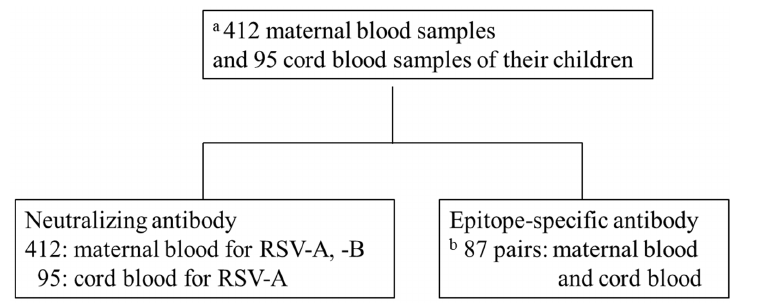
Figure 2. Schematic diagram of analysis. ( a ) Of 9,643 births in Fukushima Prefecture from November 2011 to April 2014, 412 maternal blood (MB) and 95 cord blood (CB) samples of the offspring were available for analysis. ( b ) Eighty-seven pairs of 97 samples in which neutralizing antibodies were measured.